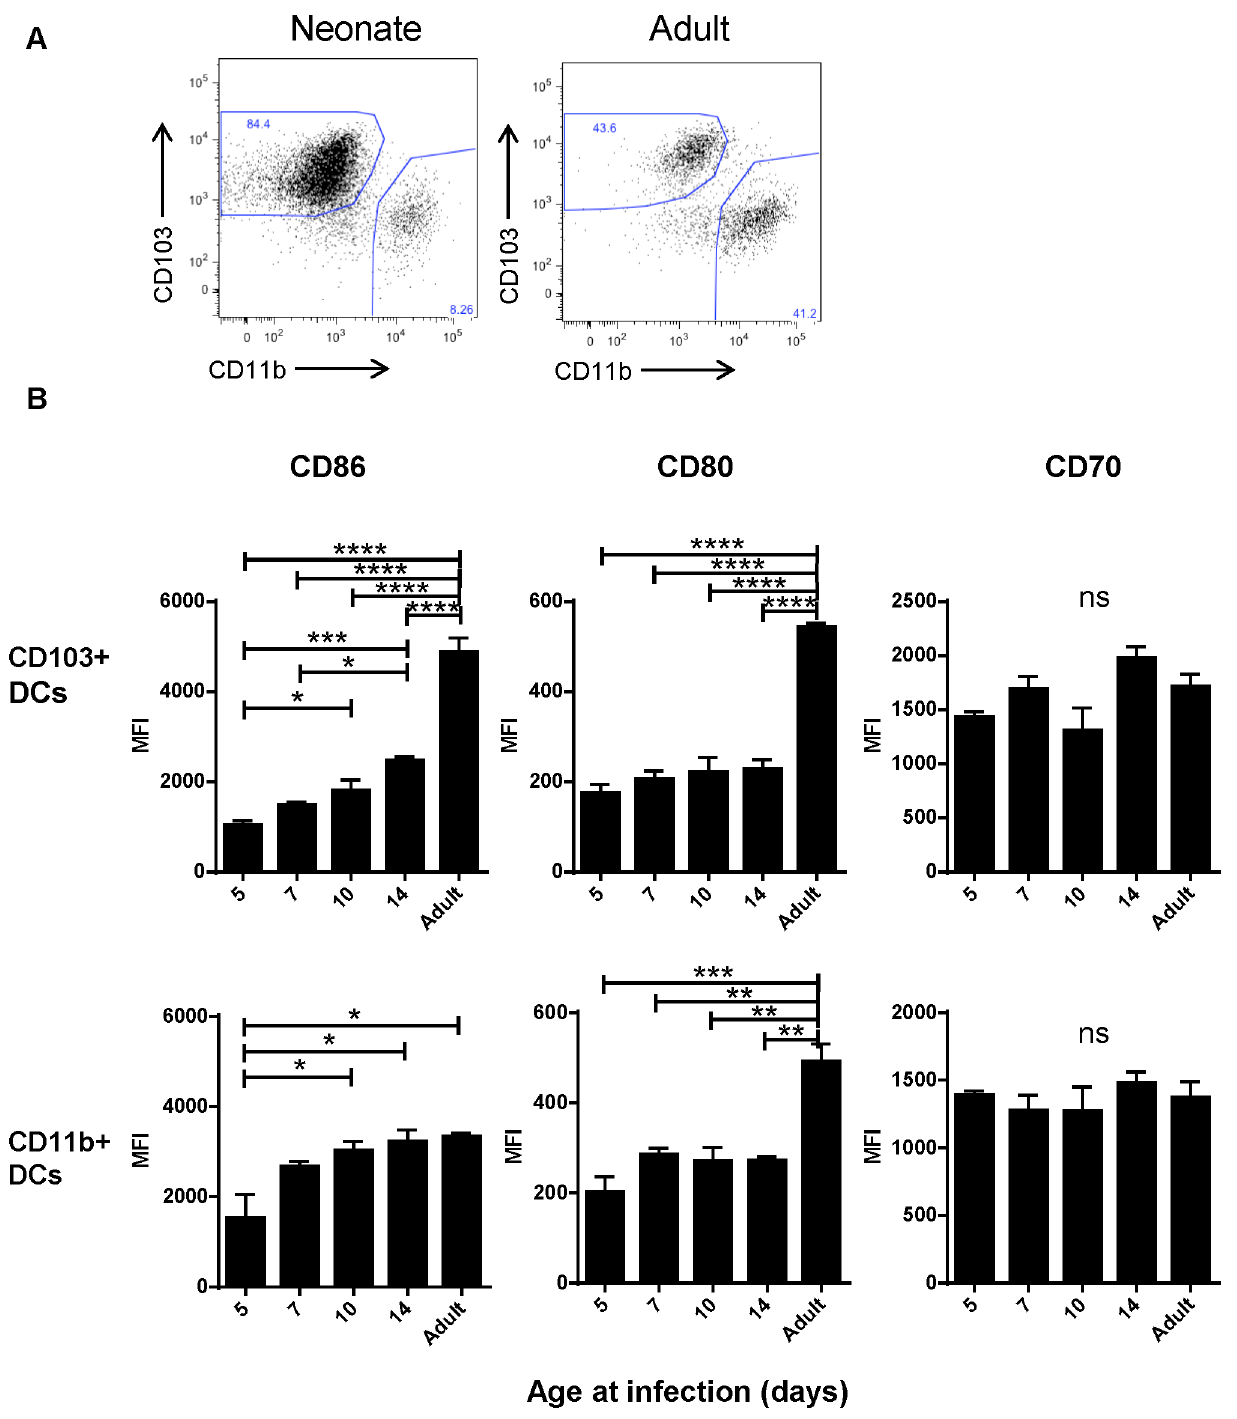
Figure 4. Age-dependent phenotypic changes in the CD103 + and CD11b + DC populations in the MLN three days post-infection. A) Evaluation of the Class II high populations of neonatal (7 days old) vs. adult mice shows differences in composition and phenotype of DC populations. B) Costimulatory molecule (CD86, CD80 and CD70) expression was measured by flow cytometry on CD103 + and CD11b + DCs three days post- infection at the indicated age and the mean fluorescence intensity (MFI) is displayed. Data are representative of three experiments using two to three samples of lymph nodes pooled from 3–7 mice. Error bars indicate the SEM, and all data was analyzed using one-way ANOVA with Tukey’s multiple comparisons test (* p # 0.05, ** p # 0.01, *** p # 0.001, **** p # 0.0001).